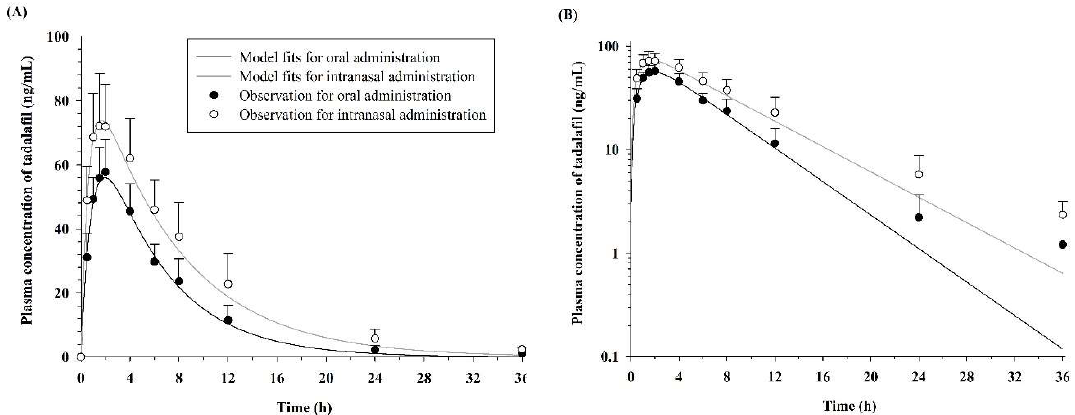
Figure 1. Mean plasma concentration–time curves ( A ) and the corresponding graph converted to a semi-log scale ( B ) for the oral and intranasal administration of 5 mg tadalafil in dogs. Each point represents the mean ± standard deviation (SD). Solid lines indicate the final model fits.